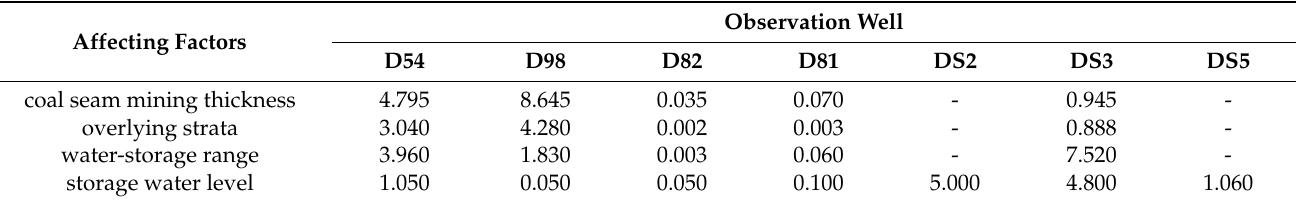
Table 4. Absolute sensitivity coefficient values for each influencing factor of the observation